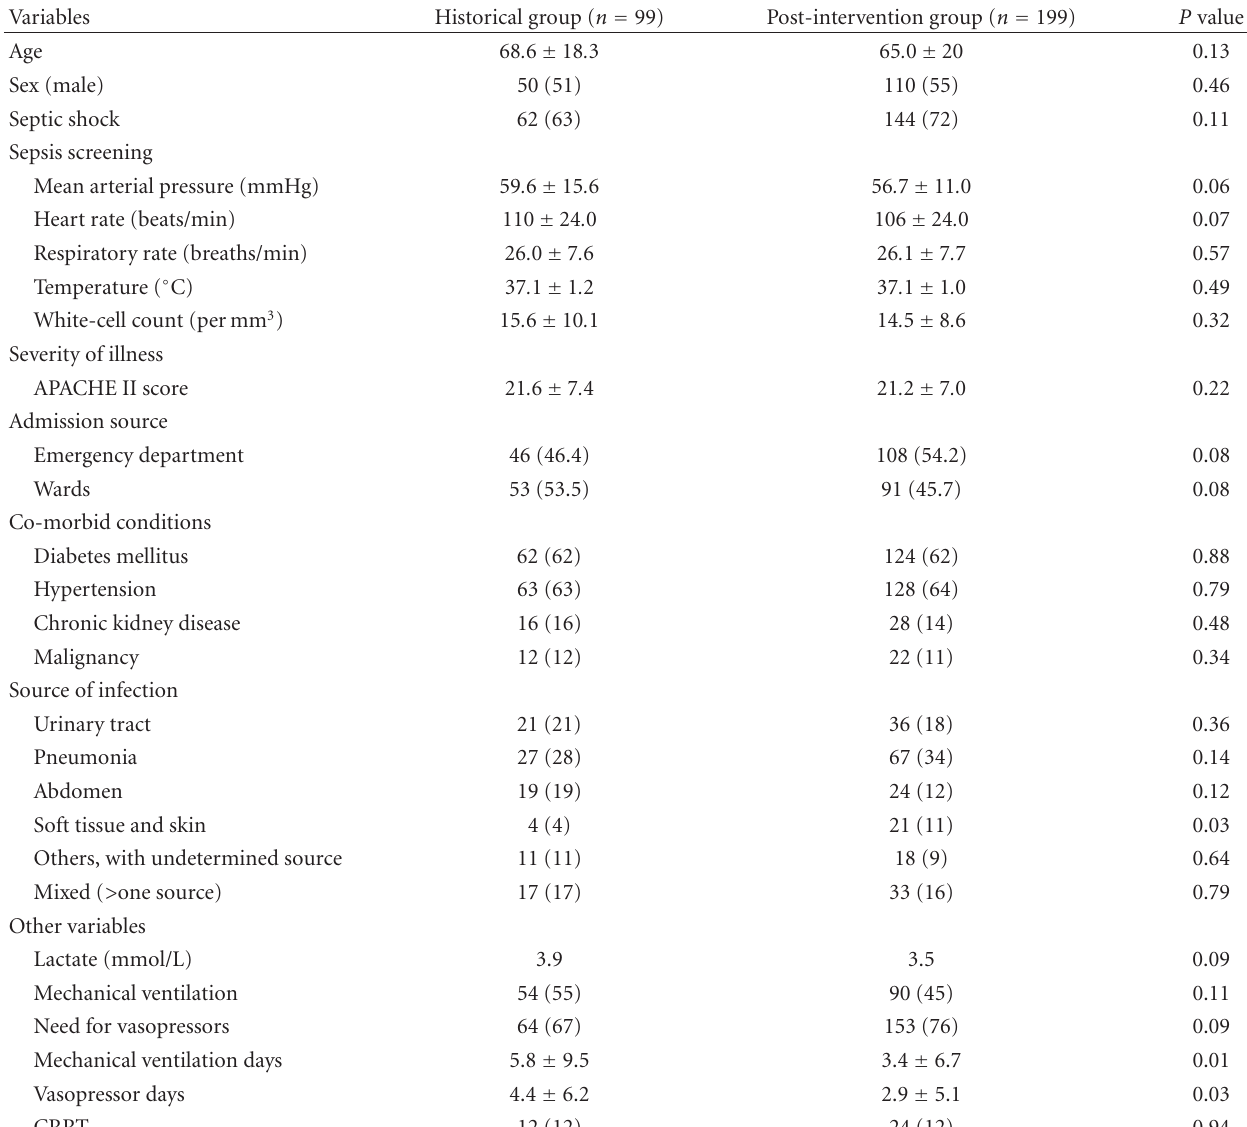
Table 1: Patients characteristics and clinical